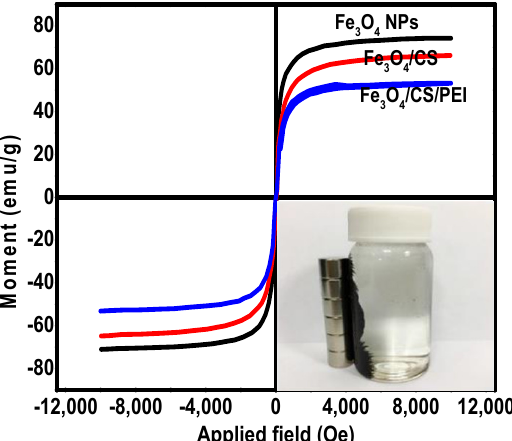
Figure 3. Magnetization curves (inset: magnetic separation of Fe 3 O 4 /CS/PEI nanocomposite) of the synthesized Fe 3 O 4 NPs, Fe 3 O 4 /CS, and Fe 3 O 4 /CS/PEI nanomaterials.